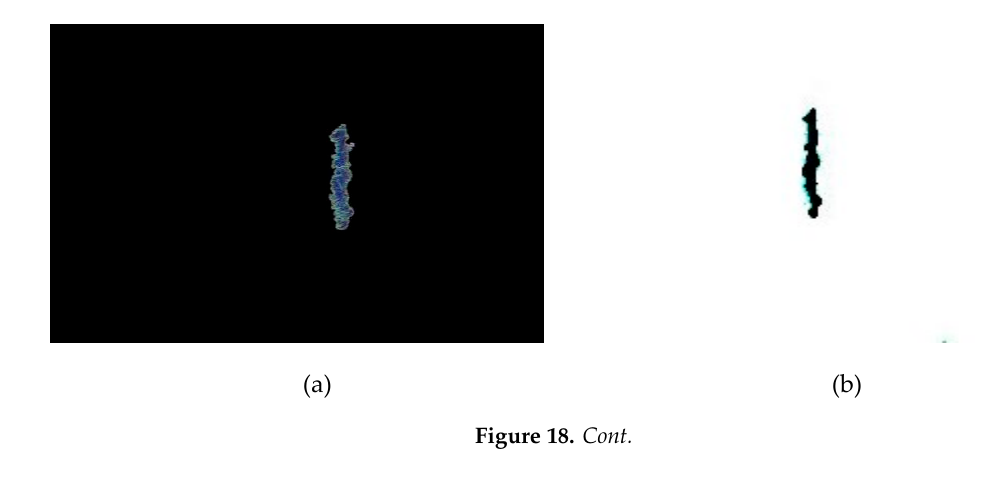
Figure 17. The segmentation results of oil pollution1 image. ( a ) 3DPCNN-HSOA ; ( b ) LSA ; ( c ) MS ; ( d ) GLCM; and ( e )Ground truth.